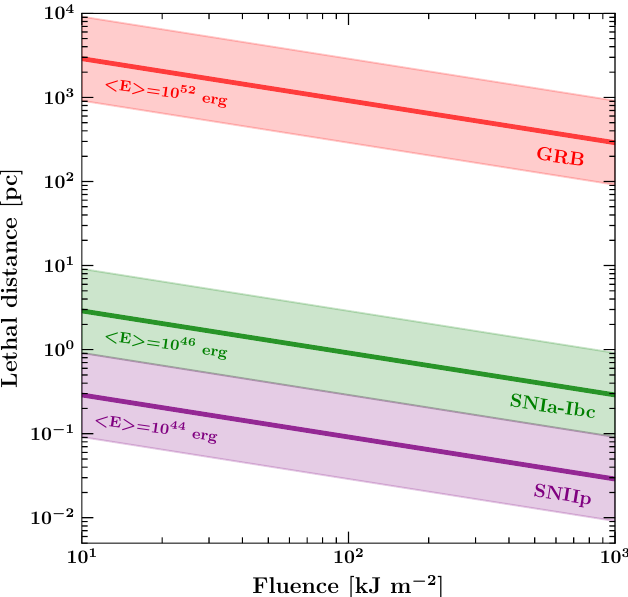
Figure 4. The lethal distance as a function of the fluence, shown by the colored solid lines for GRBs (red) and SNe (green and pink lines for Ibc and IIp, respectively). The shaded regions are obtained assuming a factor 10 variation on the assumed energy. The curves are derived from Equation (1), assuming the characteristic energy E was as